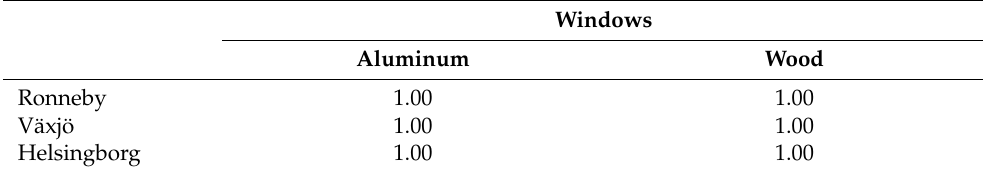
Table 9. U-values (W/m 2 K) of cost-optimal windows, using different frame materials, under different scales of district heating systems and district heat price.